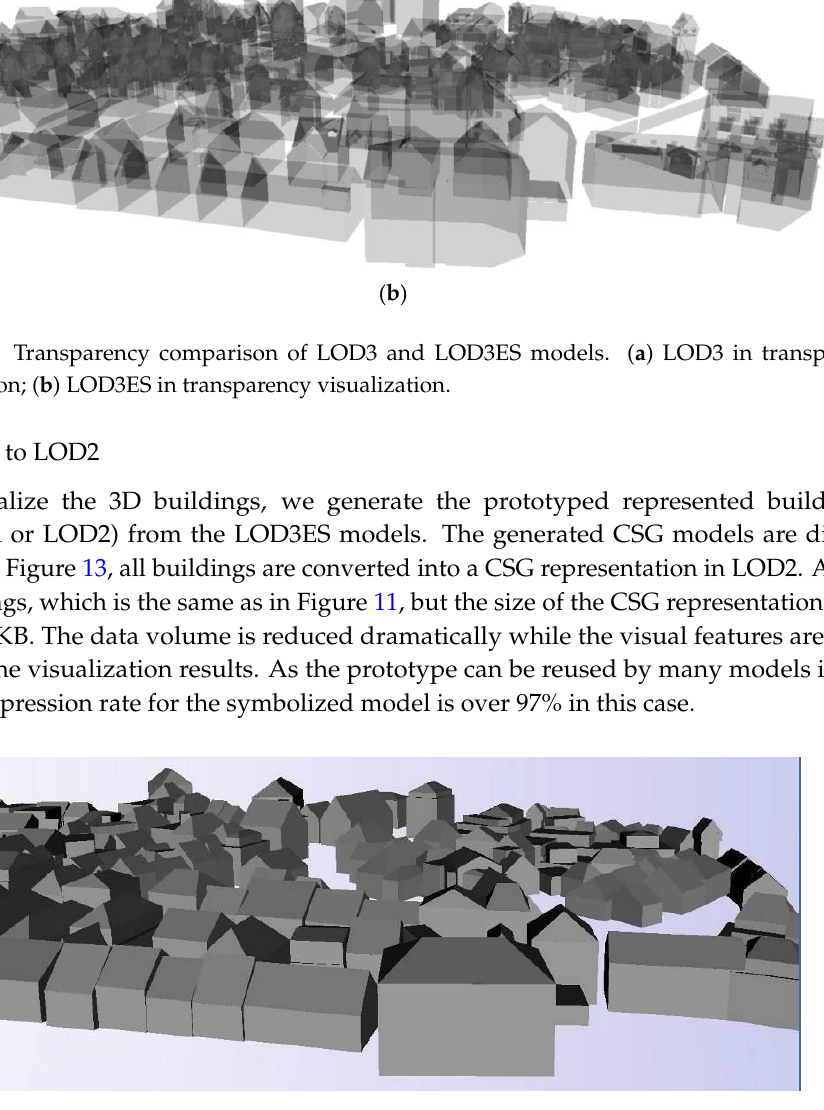
Figure 13. CSG representation of 3D city models (LOD2). Figure 13 CSG representation of 3D city models (LOD2). Figure 13 CSG representation of 3D city models (LOD2).